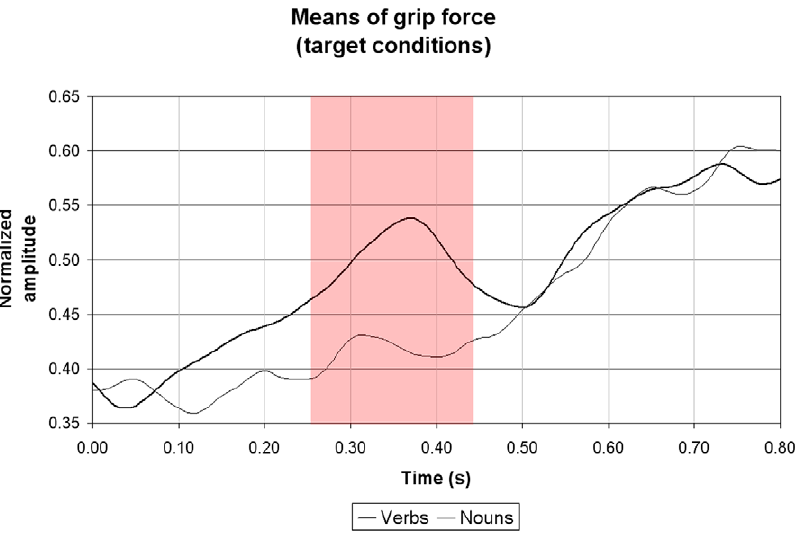
Figure 3. Normalized grip force amplitude. Grand average of normalized grip force amplitude of verbs and nouns –when they are targets– between the onset of a stimulus word until the end of the longest word duration. Compared to the nouns, the presence of verbs induced an early change in the signal following word onset. The shaded portion of the graph, starting at 260 ms and ending at 430 ms, shows the area where the two curves are significantly different (p , 0.05).